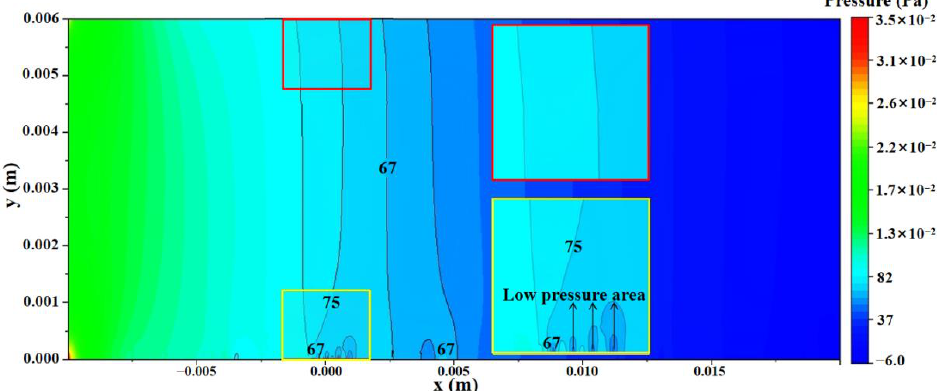
Figure 17. Pressure cloud diagram of the x-y cross-section.